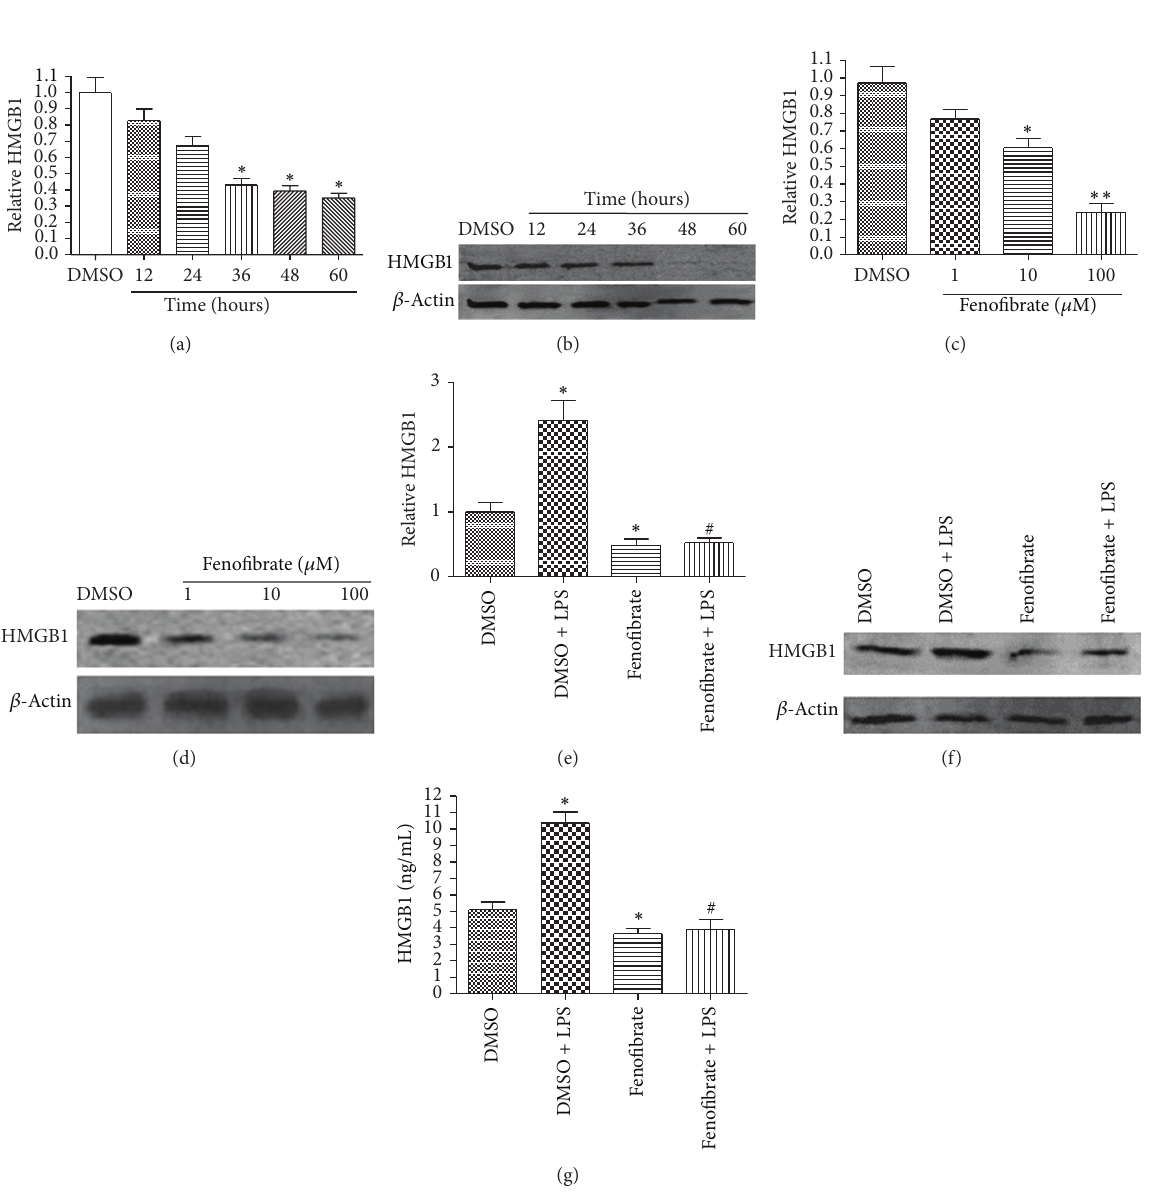
Figure 1: Fenofibrate inhibits the basal and LPS-induced expression of HMGB1. (a) and (b) Fenofibrate induces time-dependent inhibition of the expression of HMGB1 in primary cardiomyocytes at the mRNA level (a) and protein level (b). Cells were treated with 10 𝜇 M fenofibrate for 12, 24, 36, 48, and 60h before being used for experiments. (c) and (d) Fenofibrate-induced concentration-dependent inhibition of the expression of HMGB1 in primary cardiomyocytes at the mRNA level (c) and protein level (d). Cells were treated with 1, 10, and 100 𝜇 M fenofibrate for 36h before experiments. (e) and (f) Fenofibrate inhibited basal and LPS-induced HMGB1 expression in cardiomyocytes as determined by real-time PCR (e) and western blot (f). Cells were treated with the DMSO vehicle or the same dose of fenofibrate at a final concentration of 10 𝜇 M for 36 h; LPS (50 ng/mL) was then added and incubated for 10h. (g) Fenofibrate inhibits basal and LPS-induced secretion of HMGB1 in cardiomyocytes; similar treatments were performed as described for (e) and (f), and the HMGB1 level was analyzed by ELISA. All the data are representative of at least three independent experiments, and the data in (a), (c), (e), and (g) are presented as the mean ± SEM. ∗ 𝑃 < 0.05 versus DMSO vehicle and # 𝑃 < 0.05 versus LPS